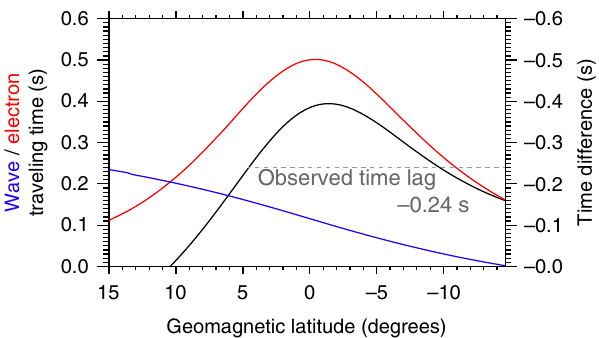
Fig. 2 Theoretical time difference between chorus waves and electrons. Blue and red curves indicate the wave and electron traveling times. The dotted line indicates the observed time lag of − 0.24 s for reference. Cross points between the black curve and the dotted line indicate the